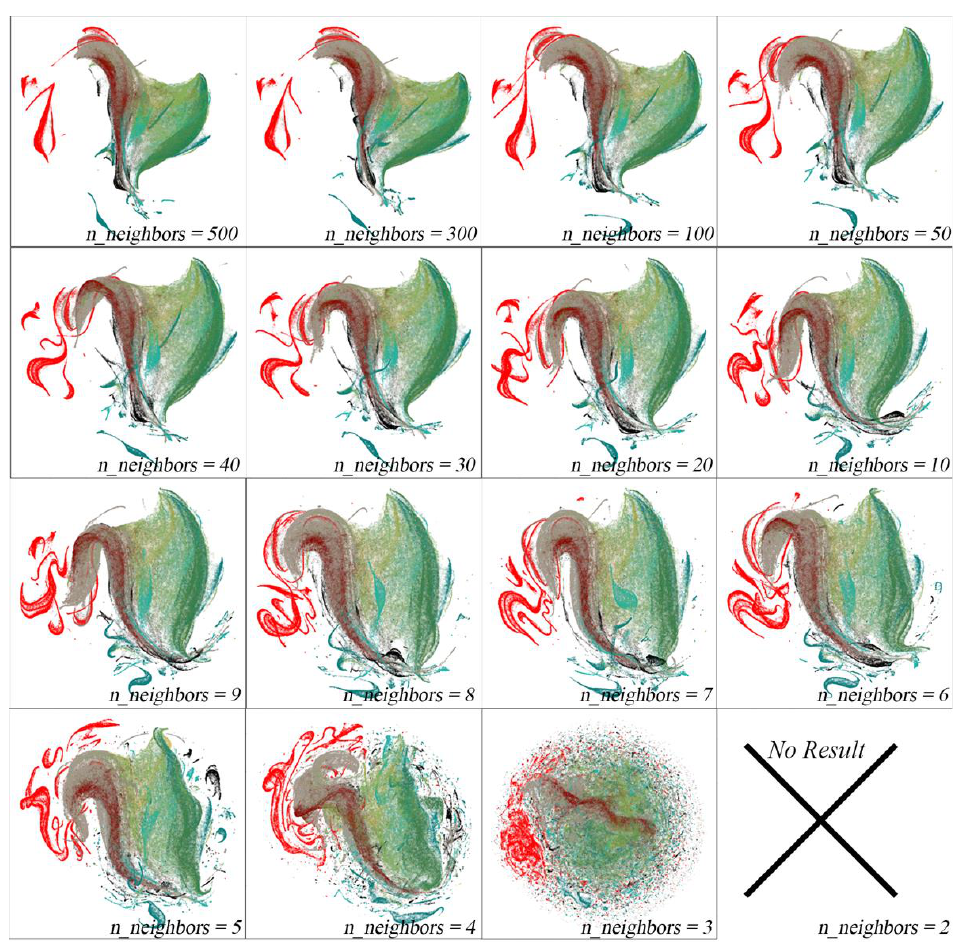
Figure A1. UMAP dependence on n_neighbors parameter. UMAP results for the image mosaic are shown for a range of n_neighbors parameter settings. All runs use min_dist = 0.1 and Euclidean distance